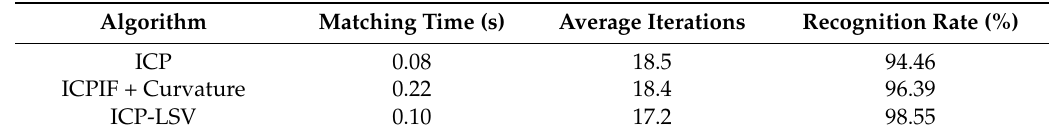
Table 4. Comparison of different algorithms on UND-J2 database 1 .